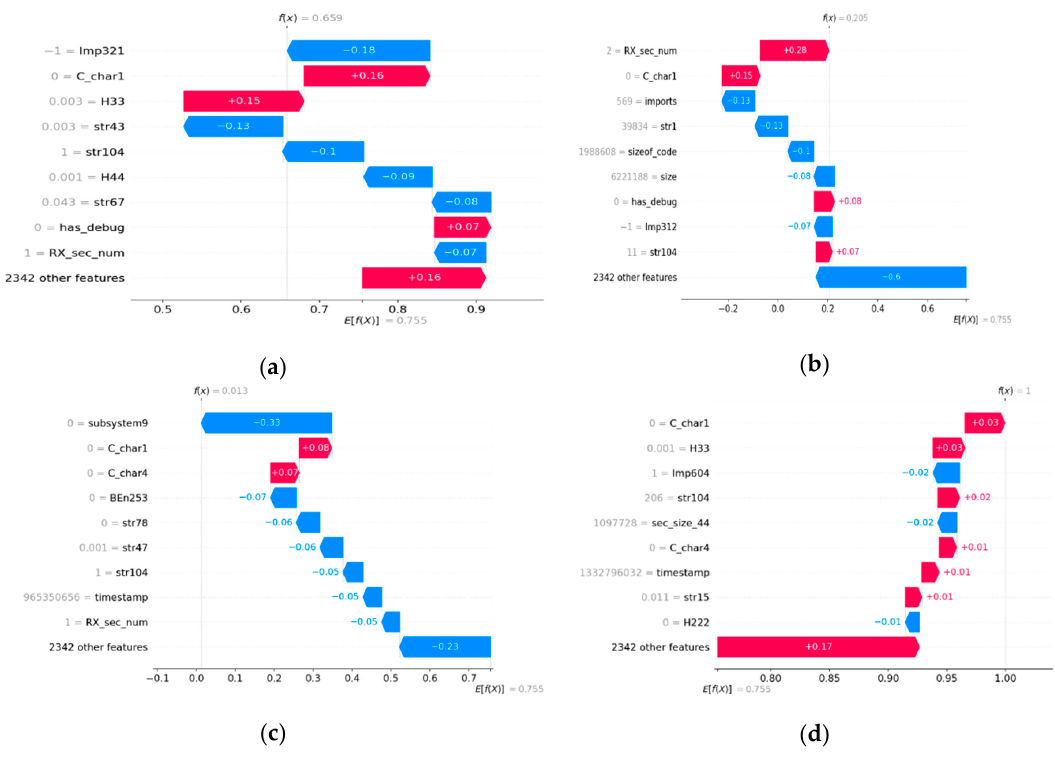
Figure 7. Waterfall plot of a FP sample ( a ), a FN sample ( b ), a TP sample ( c ), and a TN sample ( d ) from the D2 dataset on probability